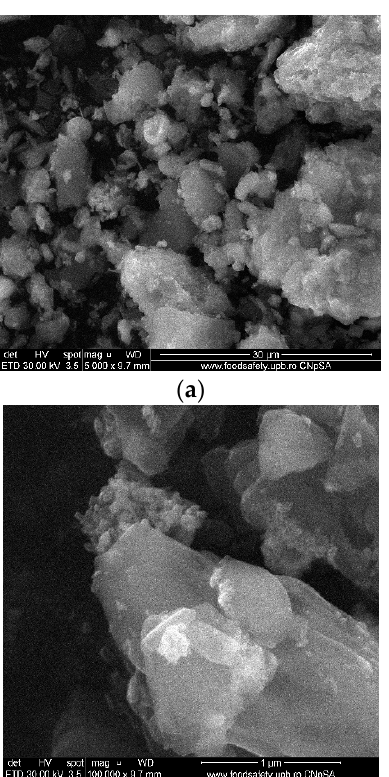
Figure 4. XRD pattern for ZnO nanoparticles.